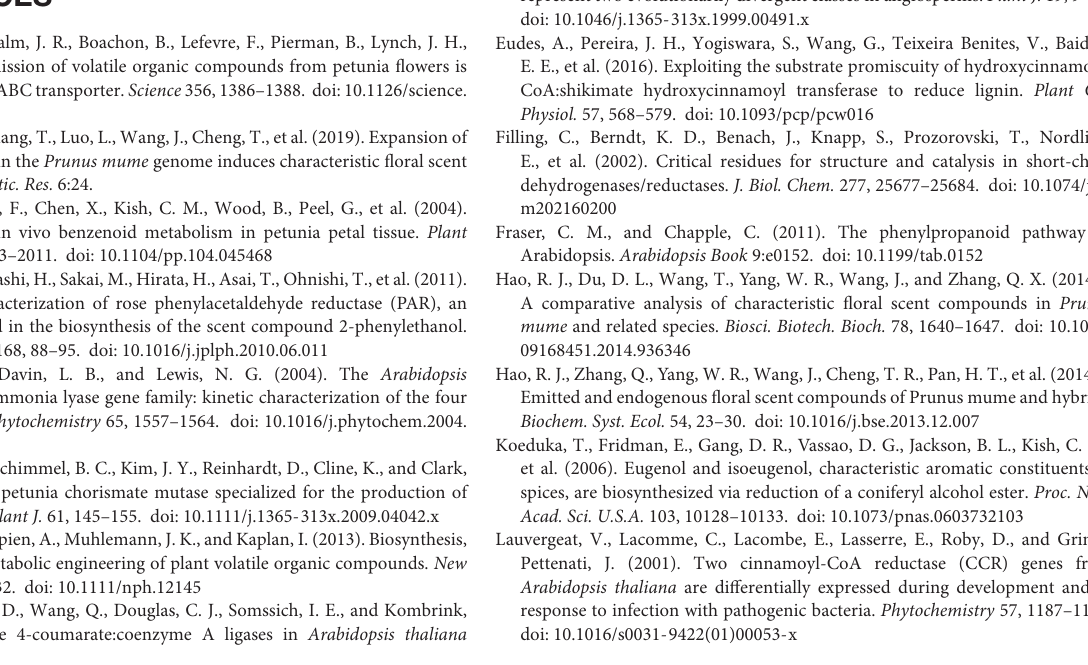
Supplementary Table 10 | Interaction values between 6 metabolites and 100 selected genes. Supplementary Table 11 | Information on selected genes in the interaction networks. Supplementary Table 12 | The primer sequences for qPCR. Supplementary Table 13 | qPCR validation of transcript levels evaluated by